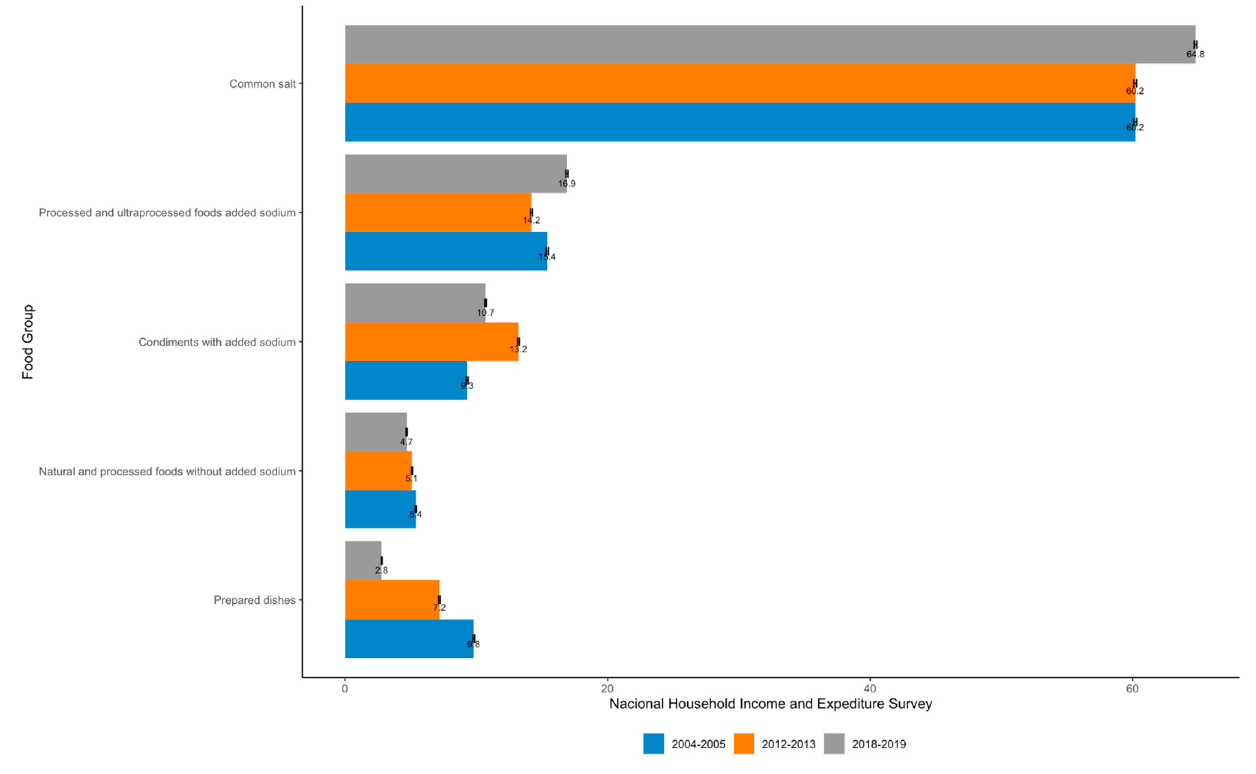
Figure 4. Dietary sources of sodium in Costa Rican households (%) by food group and National Household Income and Expenditure Survey 2004–2005, 2012–2013 and 2018–2019. In the 2004–2019 period, a nonlinear increase with income level was found in com- mon salt contribution (60.2 to 64.8%). An increase in processed and UP foods with added sodium was observed (15.4 to 16.9%), as well as a decrease in fresh or processed and UP foods without added salt (5.4 to 4.7%) and prepared dishes (9.8 to 2.8%). In the 2012 to 2019 period, there was a reduction in condiments with added sodium (from 13.2 to 10.7%) and in prepared dishes (from 7.2 to 2.8%). 4. Discussion Historically, salt has been considered a basic element to provide food with flavor, for food conservation and for food product formulation. Its consumption exceeds targets es- tablished by WHO and PAHO [5–7], which is particularly concerning given its association with HBP, CVD risk [2] and overall morbidity and mortality [2,6]. In CR this intake sur- passes previously mentioned targets [5–7], not only nationally but also by geographic area and planning region. The average of sodium available for consumption in 2018–2019 was 3.84 g/person/day, matching what has been reported worldwide (65% consumes between 8–10 and 95% between 6–12 g of salt [30]), and what Carrillo-Larco et al. [31] have pointed out regarding sodium intake in Latin America and the Caribbean. The Caribbean Huetar region showed one of the highest sodium availabilities which could be related to its higher Afro-descendant population percentage in CR, globally associated with a higher HBP prevalence [32]. There was no linear relationship between income level (quintiles) and available so- dium for consumption. However, for the first quintile this was 4.01 g/person/day adjusted to 2000 kcal, while for the fifth it was 3.50 g/person/day adjusted to 2000kcal. It is known that poor families’ low diet quality is greatly determined by the difference between monthly per capita consumption expenditure between high- and low-income families [13,33]. According to the last three ENIGHs, food expenditure in higher income